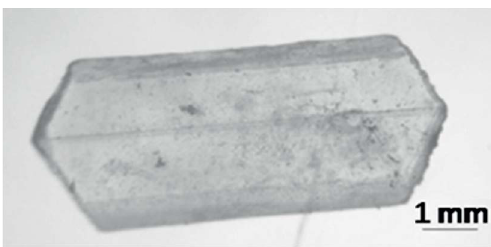
Fig. 1. Optical micrograph is showing the crystal structure of struvite obtained from E. aestuarii St. SR 101.